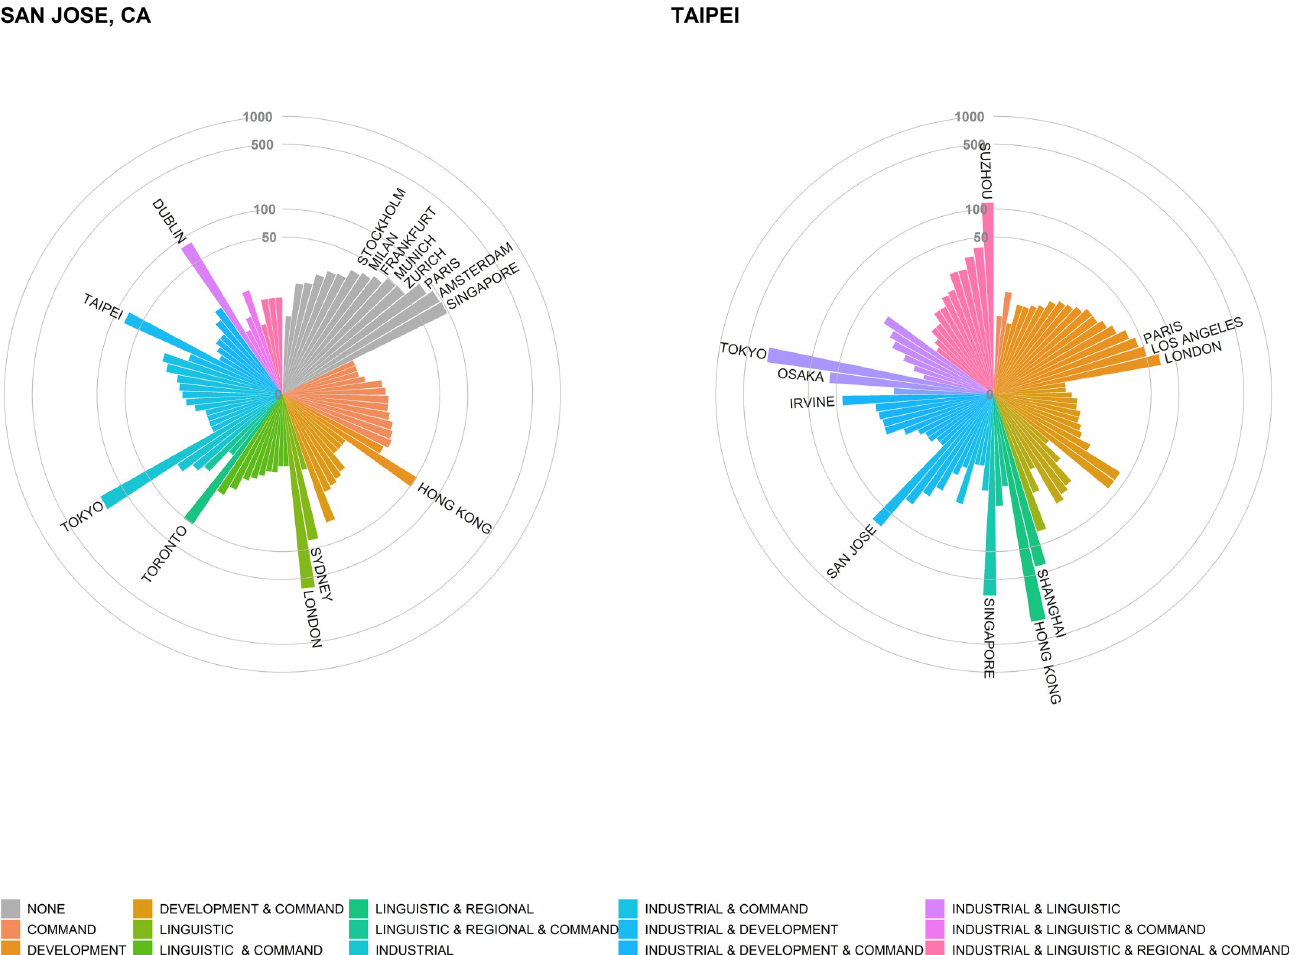
Fig 5. The ego-networks of San Jose, CA and Taipei. Ties with weights more than five are shown. Labels of cities are shown for ties with weights of 20 and